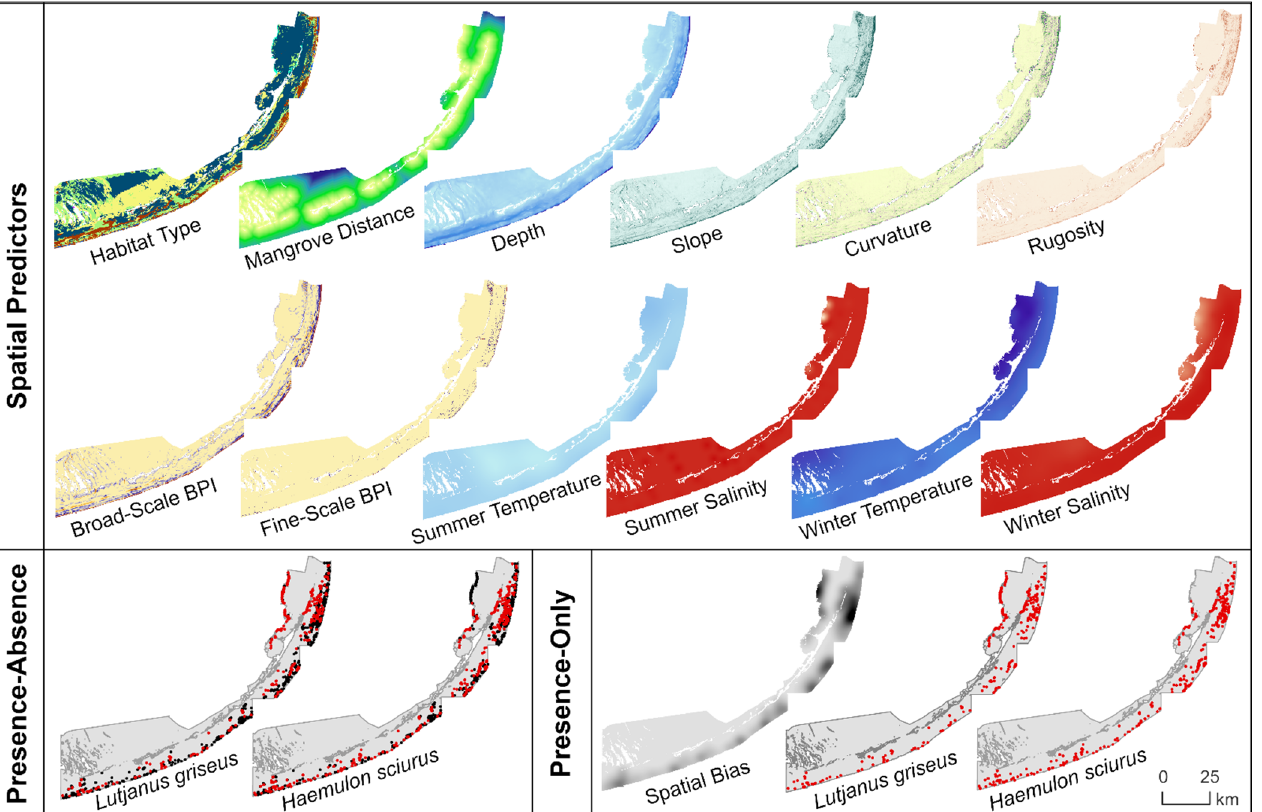
Figure 2. Maps of spatial predictors and sub-adult gray snapper ( Lutjanus griseus ) and bluestriped grunt ( Haemulon sciurus ) occurrence records used to train MaxEnt models and penalized logistic regressions of habitat suitability in the Florida Keys, USA.